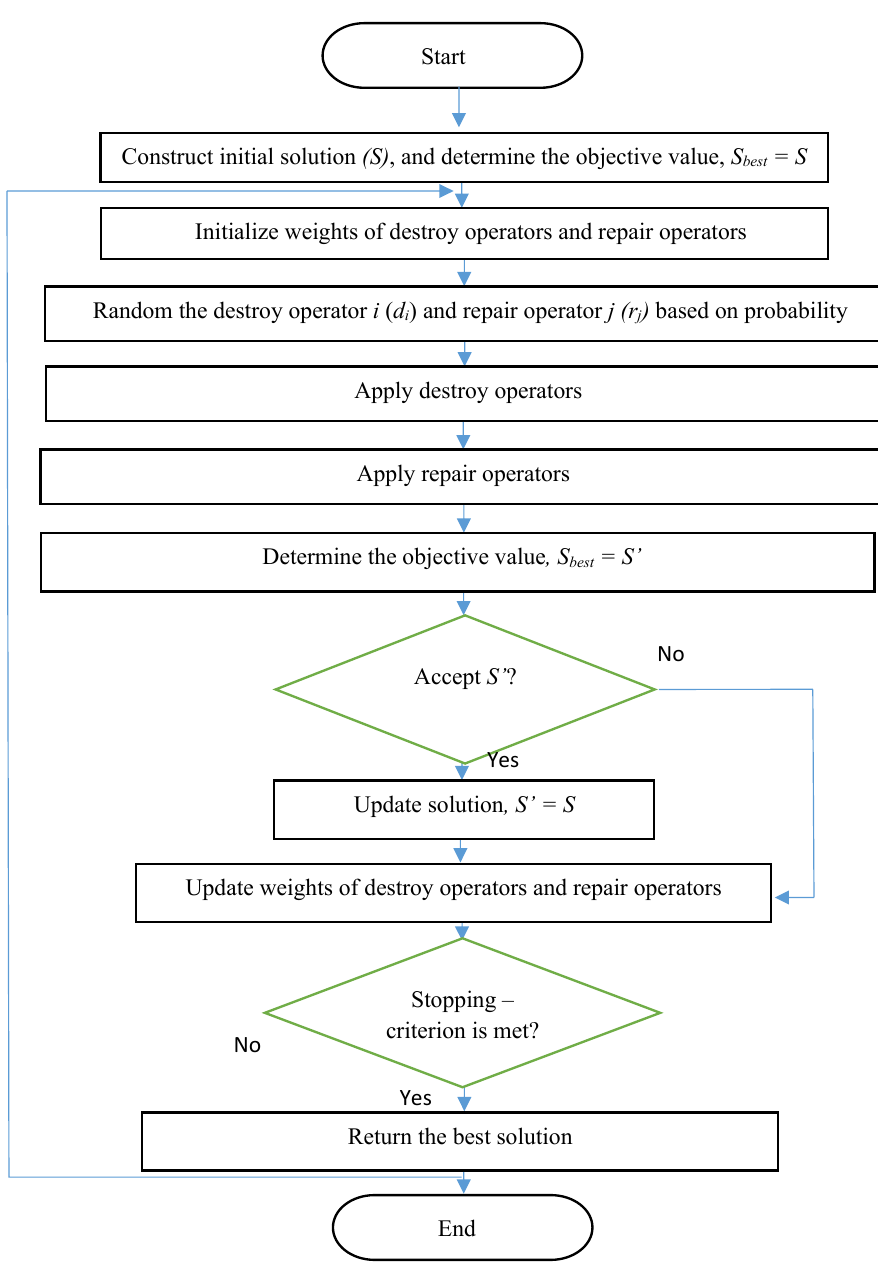
Fig.7. The steps of ALNS for phase 2: improvement